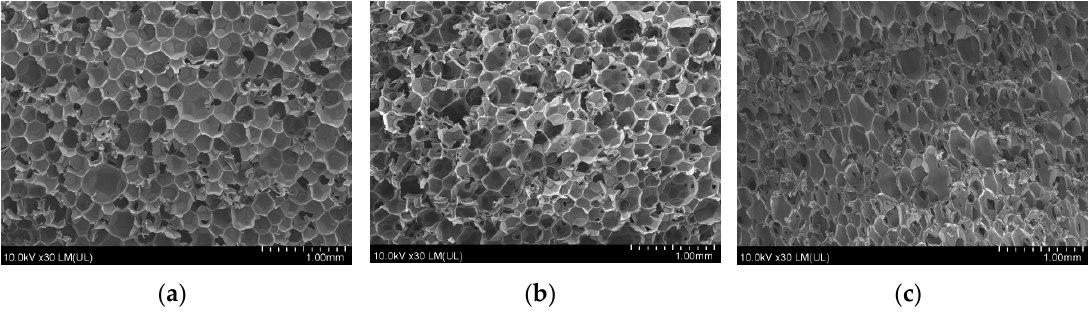
Figure 5. SEM micrographs of RPU/PIR foams surface (in parallel direction to foam rise) of reference foam ( a ) and foams modified by 30 wt.% ( b ) and 60 wt.% ( c ) of rapeseed cake.